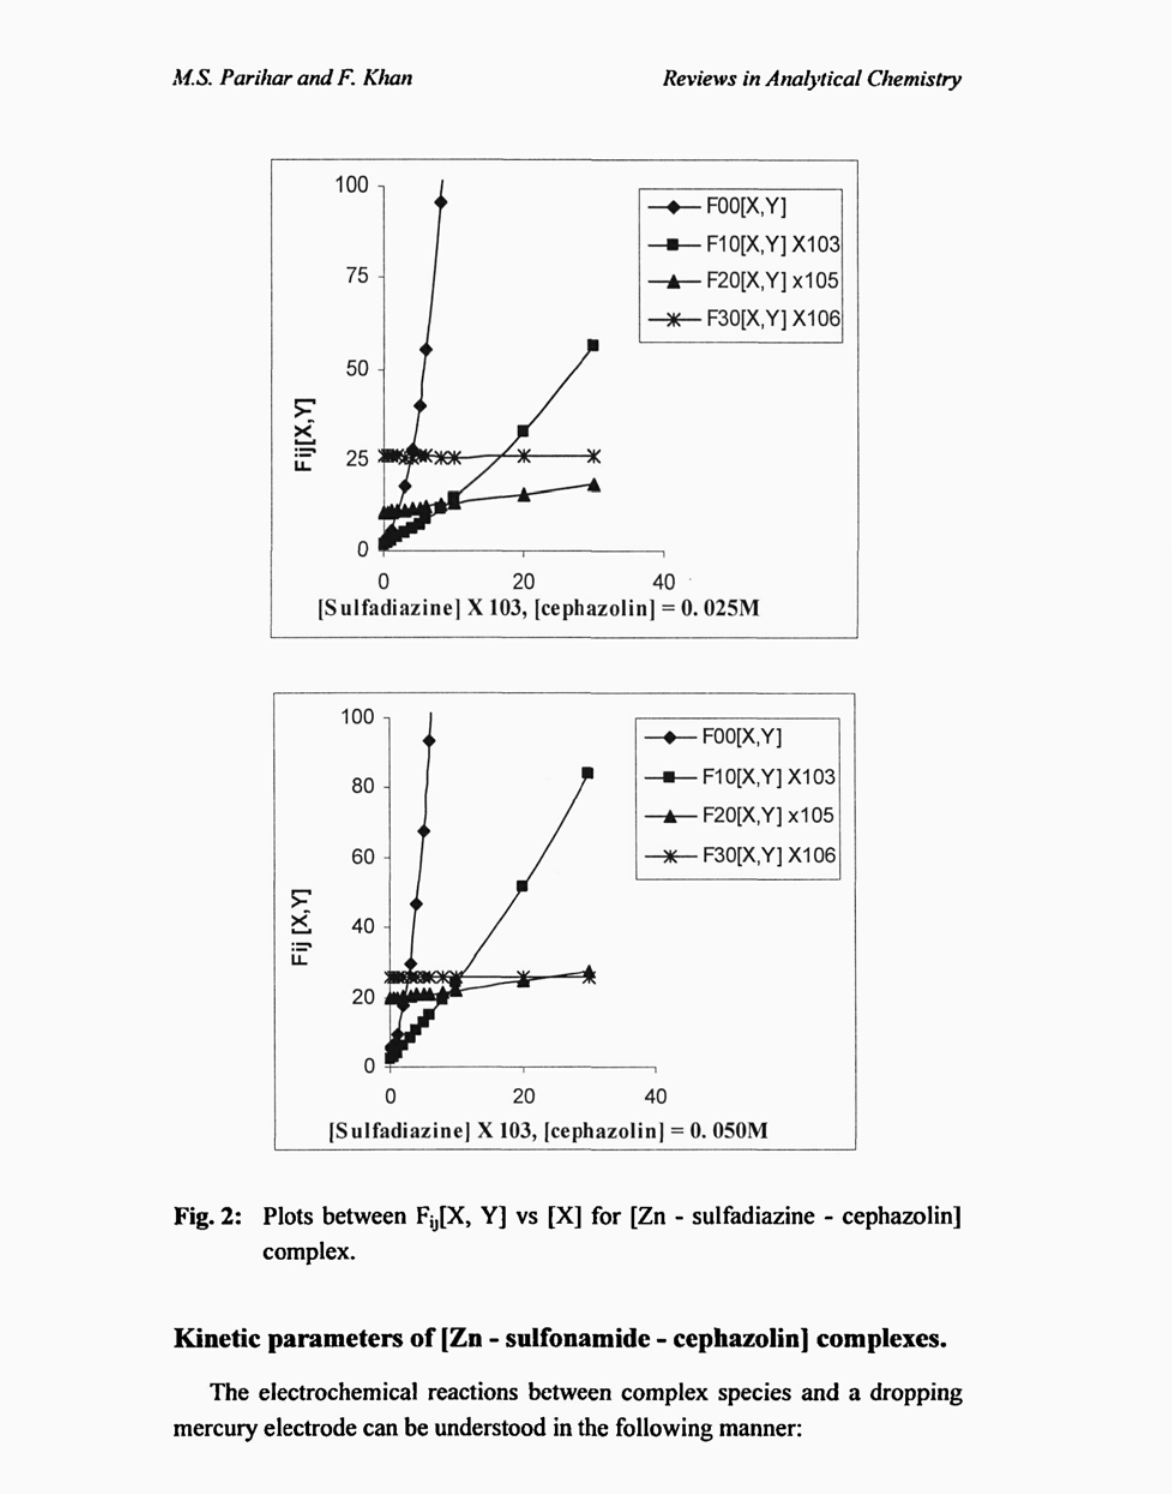
Fig. 2: Plots between Fy[X, Y] vs [X] for [Zn - Sulfadiazine - cephazolin]